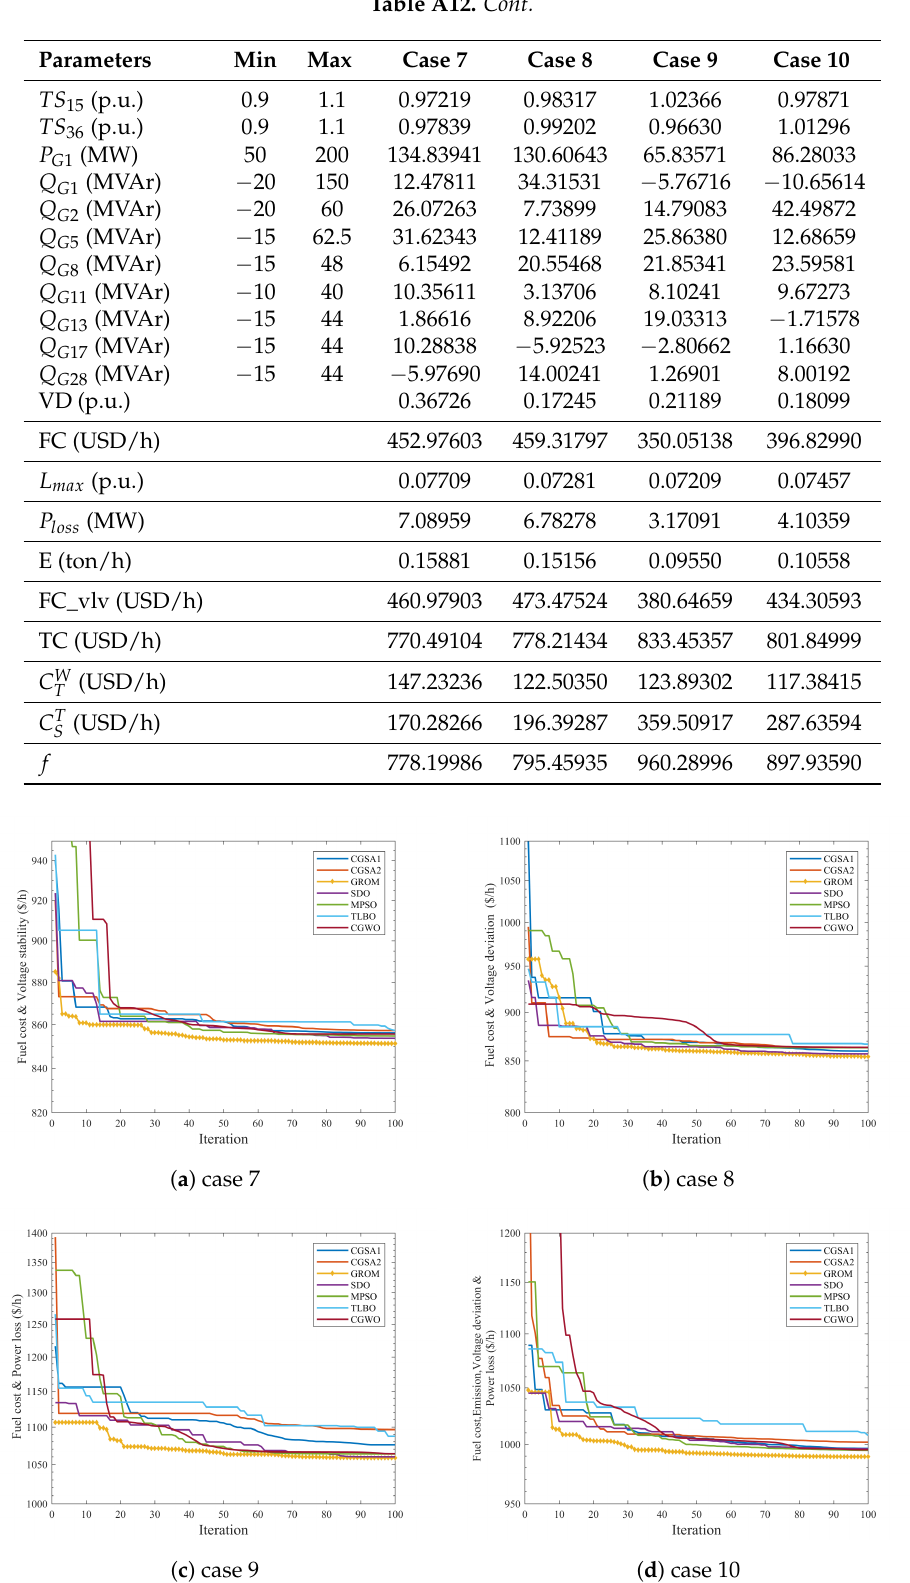
Figure A3. Convergence Curves for multi-objective optimal power